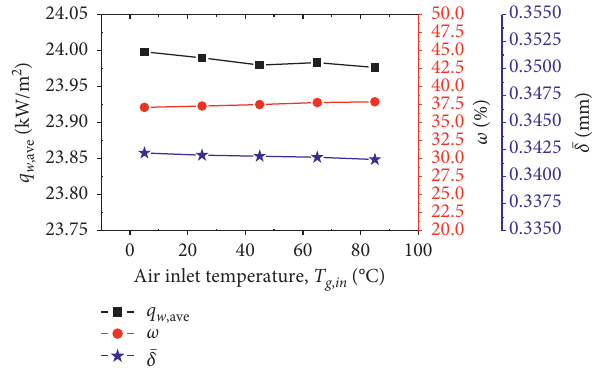
Figure 11: Influence of the air inlet temperature on heat and mass transfer of the water film evaporation process.